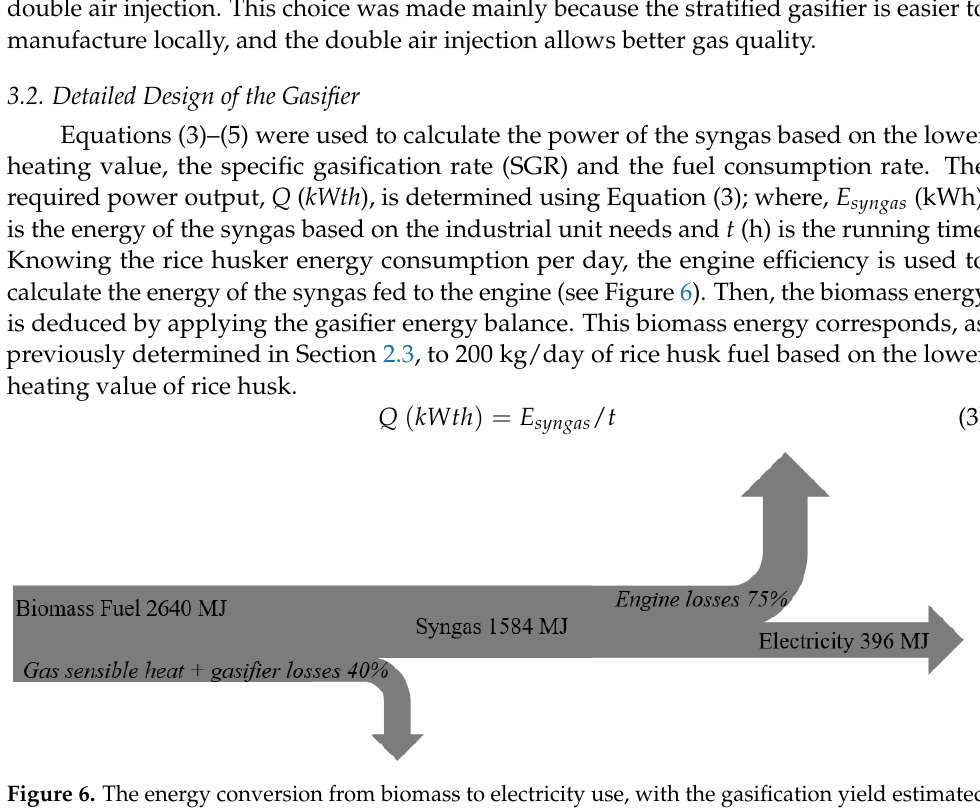
(5) Table 7 sums up the main characteristics of the designed reactor: Table 7. Specific design characteristics of the semi-batch fixed downdraft gasifier. Data